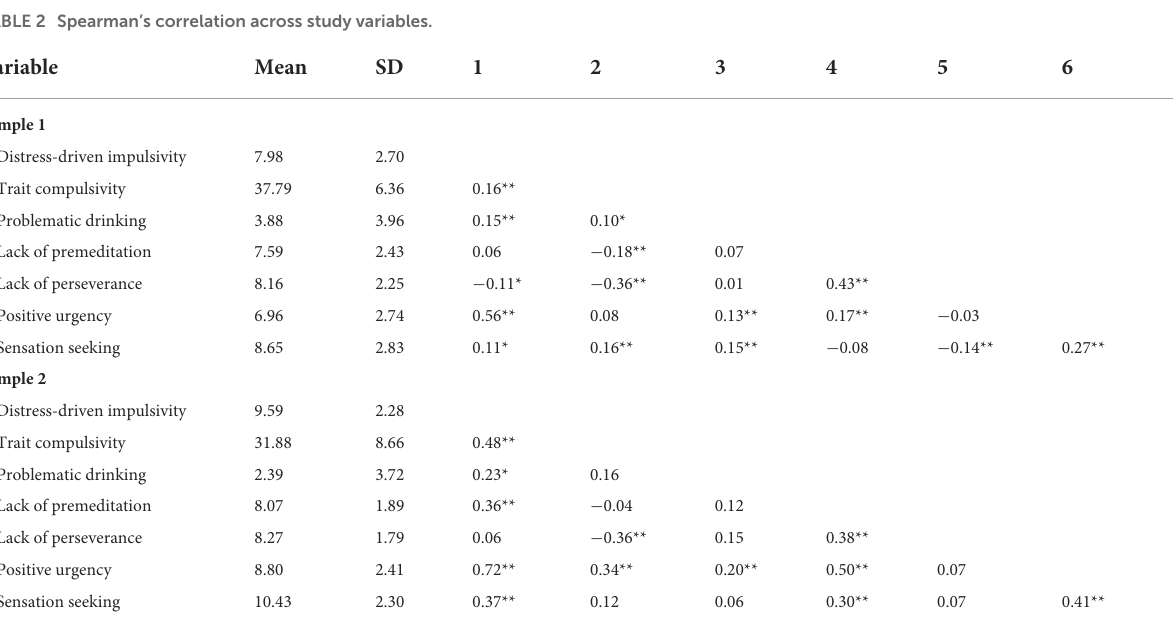
significant interaction effect was identified when the 95% confidence interval did not contain zero. Simple slope tests were used to plot the interaction effect. The interaction was plotted at two levels of CHIT scores (high CHIT group: scored 1 SD above mean; low CHIT group: scored 1 SD below mean). The Johnson-Neyman regions of significance is included in the Supplementary